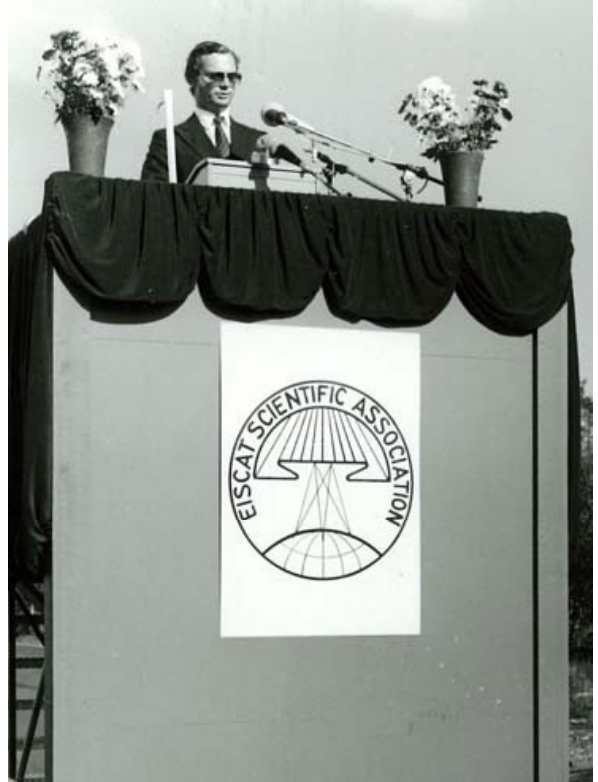
Figure 3. King Carl XVI Gustaf inaugurating EISCAT by pressing a button that gets the 32m parabolic antenna move from horizontal position to